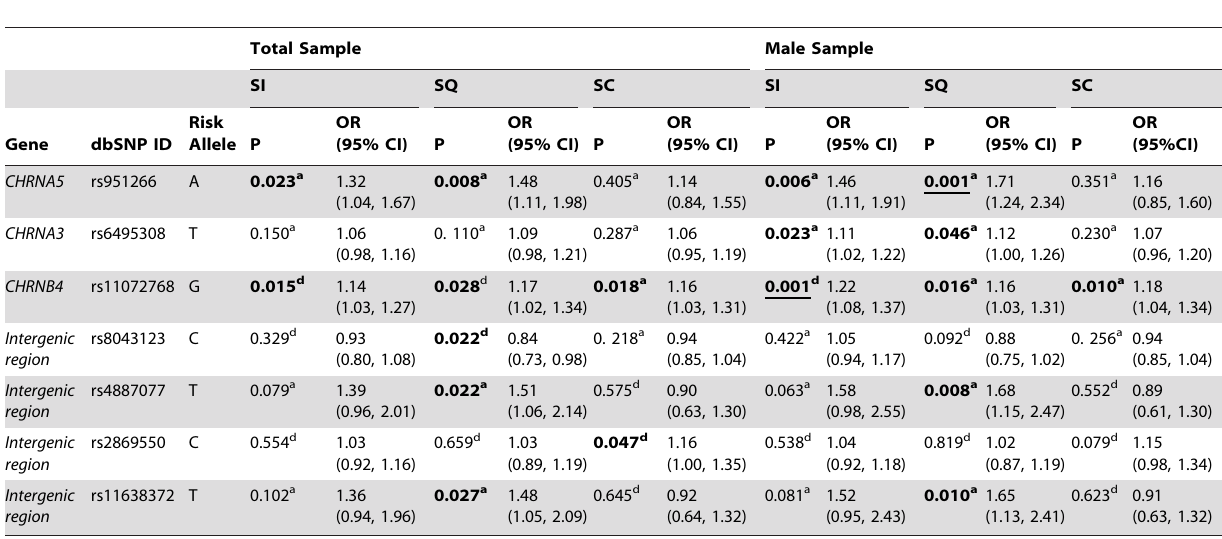
Table 2. P values for SNPs significantly associated with at least one smoking-related phenotype and their corresponding odds ratios and 95% confidence intervals under the additive and dominant